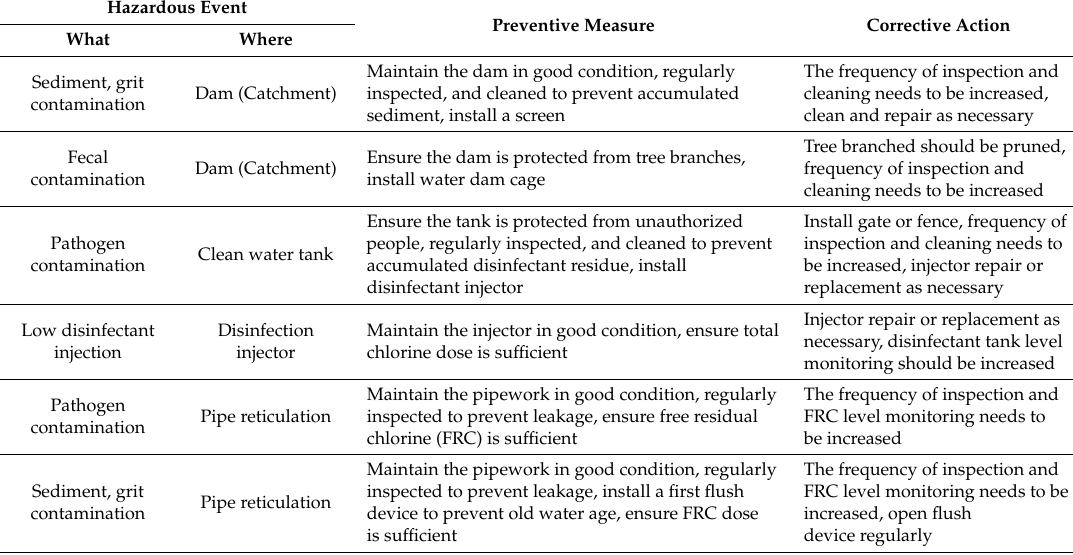
Table 5. Preventive measure and corrective action based on hazard identification and risk assessment (HIRA)